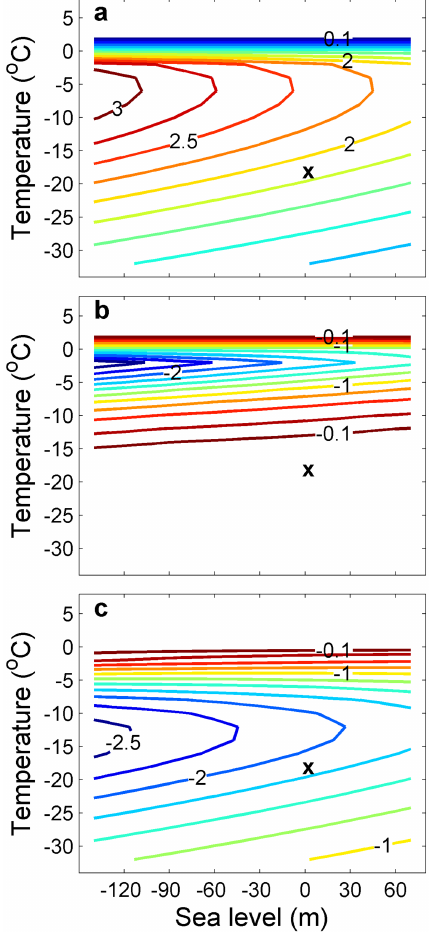
Figure 4. Sensitivity of total equilibrium volume fluxes (10 12 m 3 ice yr − 1 ) to Antarctic temperature, sea level and high-latitude, ocean subsurface temperature for the preferred model configuration (case 4 in Table 2). The volume fluxes are (a) accumulation, (b) ablation and (c) ice flux at the grounding line. The black crosses mark solutions for present-day T a , SL and T o (Table